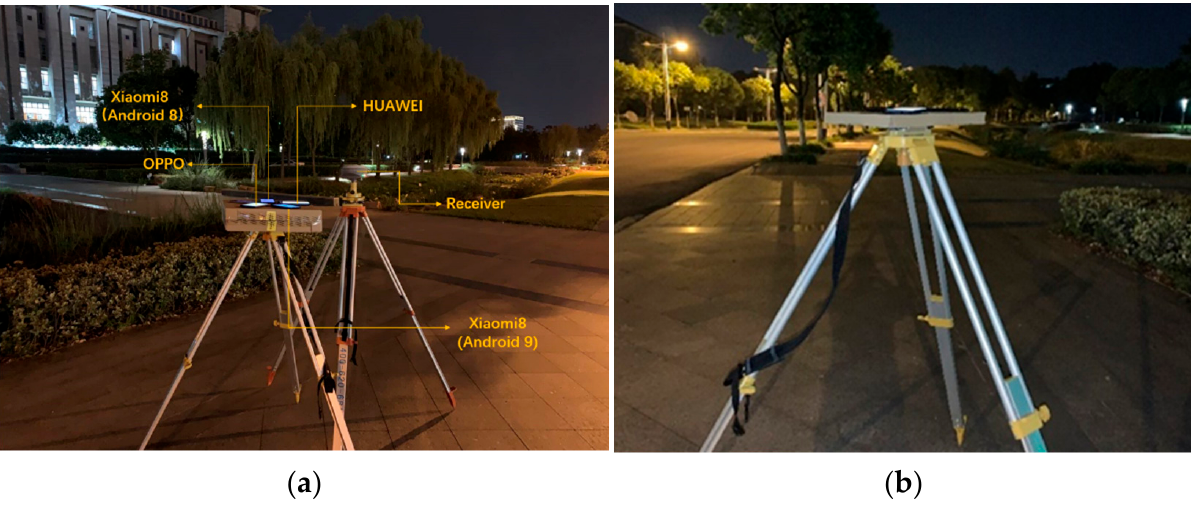
Figure 1. Schematic diagram of experimental. ( a ) Geodetic receivers and smartphones to obtain the GNSS raw observations (19 June 2020, 7 p.m.); ( b ) Positioning test on the smartphone (28 September 2020, 8